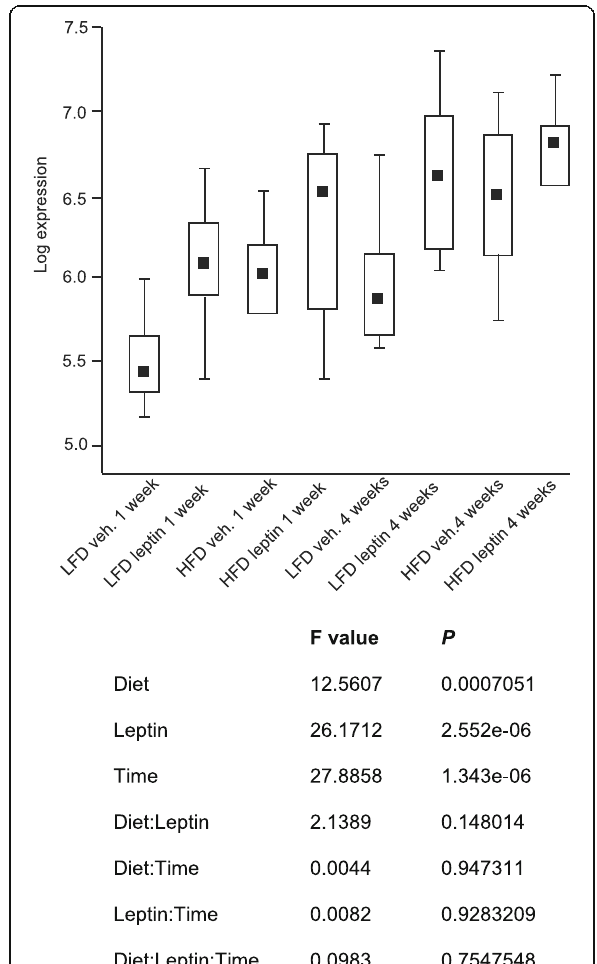
Fig. 1 Data derived from NuGO Affymetrics arrays from the hypothalamus of C57BL/6J mice maintained on a HFD or LFD for 1 and 4 weeks challenged with IP vehicle or leptin. The log of serpinA3N gene expression is represented by box and whisker plots. Three-way ANOVA showed a significant effect of diet, leptin challenge and time on the diet but no interaction between any of these factors ( n =